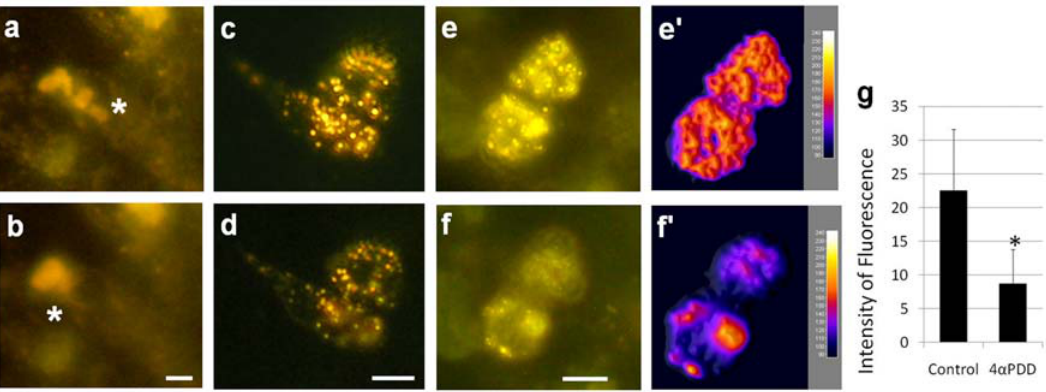
Figure 12. TRPV4 agonist induced FM1-43-loaded neurosecretory granule exocytosis. FM1–43 was injected intraperitoneally (3 mg/kg) in young rats. The following day, MCs from footpads were dissociated and cultured in isotonic medium (a, c, e). Exposure to hypotonic solution (b) or 4 a PDD 1 m M (d, f), a TRPV4 agonist, induce neurosecretory granule exocytosis, as suggested by decreases in fluorescence intensity of 61% (n=33) (g). Computational analyses showed movements of fluorescent particles from the middle to the periphery of the cells (e 9 , f 9 ) which supported exocytosis. * P , 0.01 significantly different from control. Scale bar in all pictures: 5 m m.